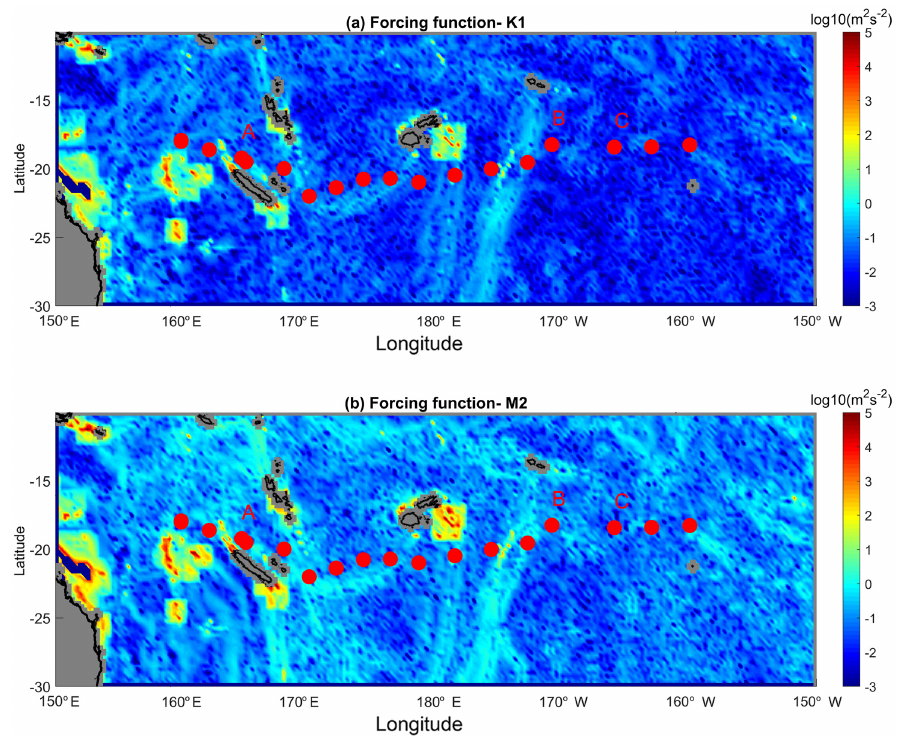
Figure 5. (a) Depth-integrated generation force for the K1 tidal constituent (log10(m 2 s − 2 )); (b) same as in (a) but for the M2 tidal con- stituent. The stations are shown with a red circle and the LD stations are